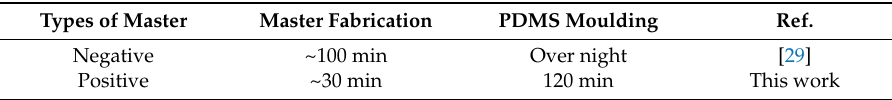
Table 4. Comparison of the time consumed between positive master and negative master in every main